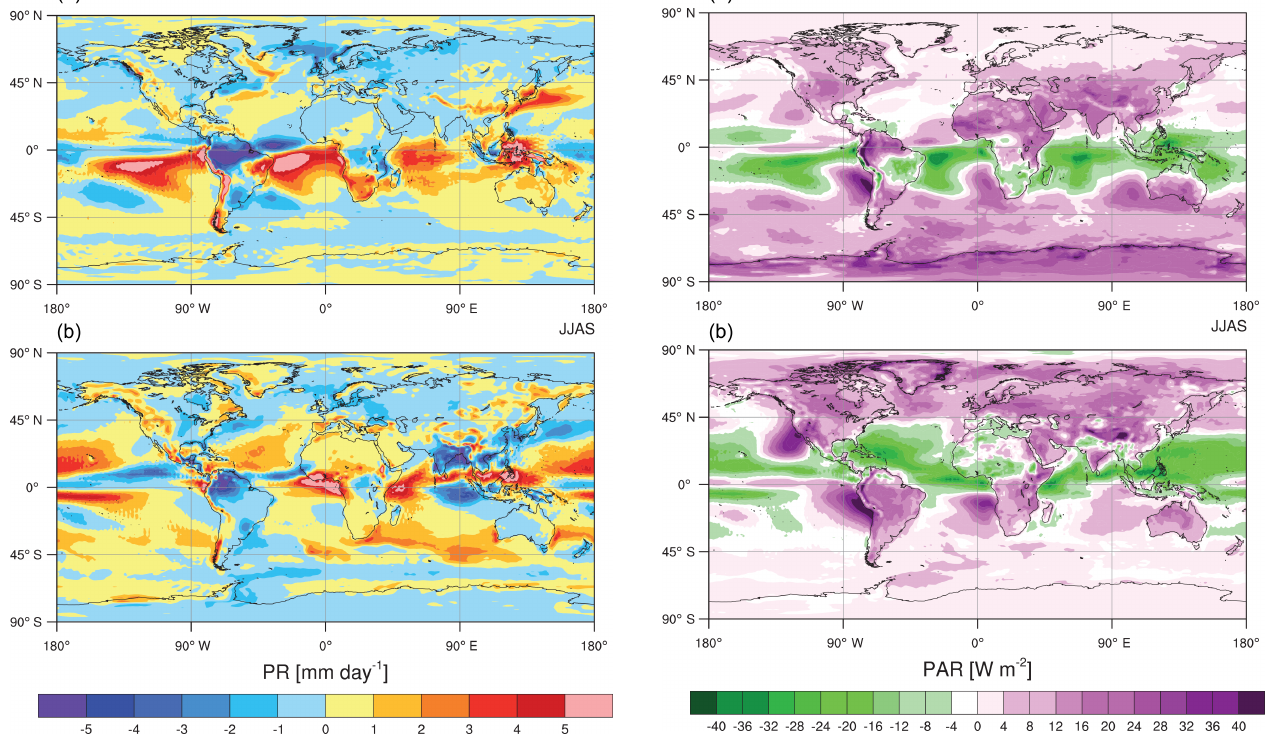
Figure 4. Biases in simulated precipitation (PR) compared to the GPCP observations (Adler et al., 2003) averaged over 1986–2005. Winter (a) and summer (b) periods are computed from DJFM and JJAS months.